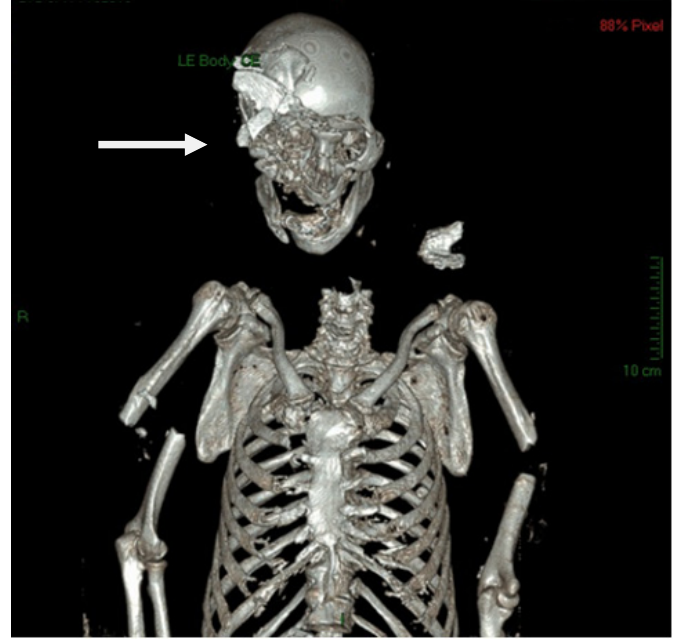
Figure 2. The PMCT showed multiple fractures on the head facing inwards and net margins inflicted by an object with a cutting edge.